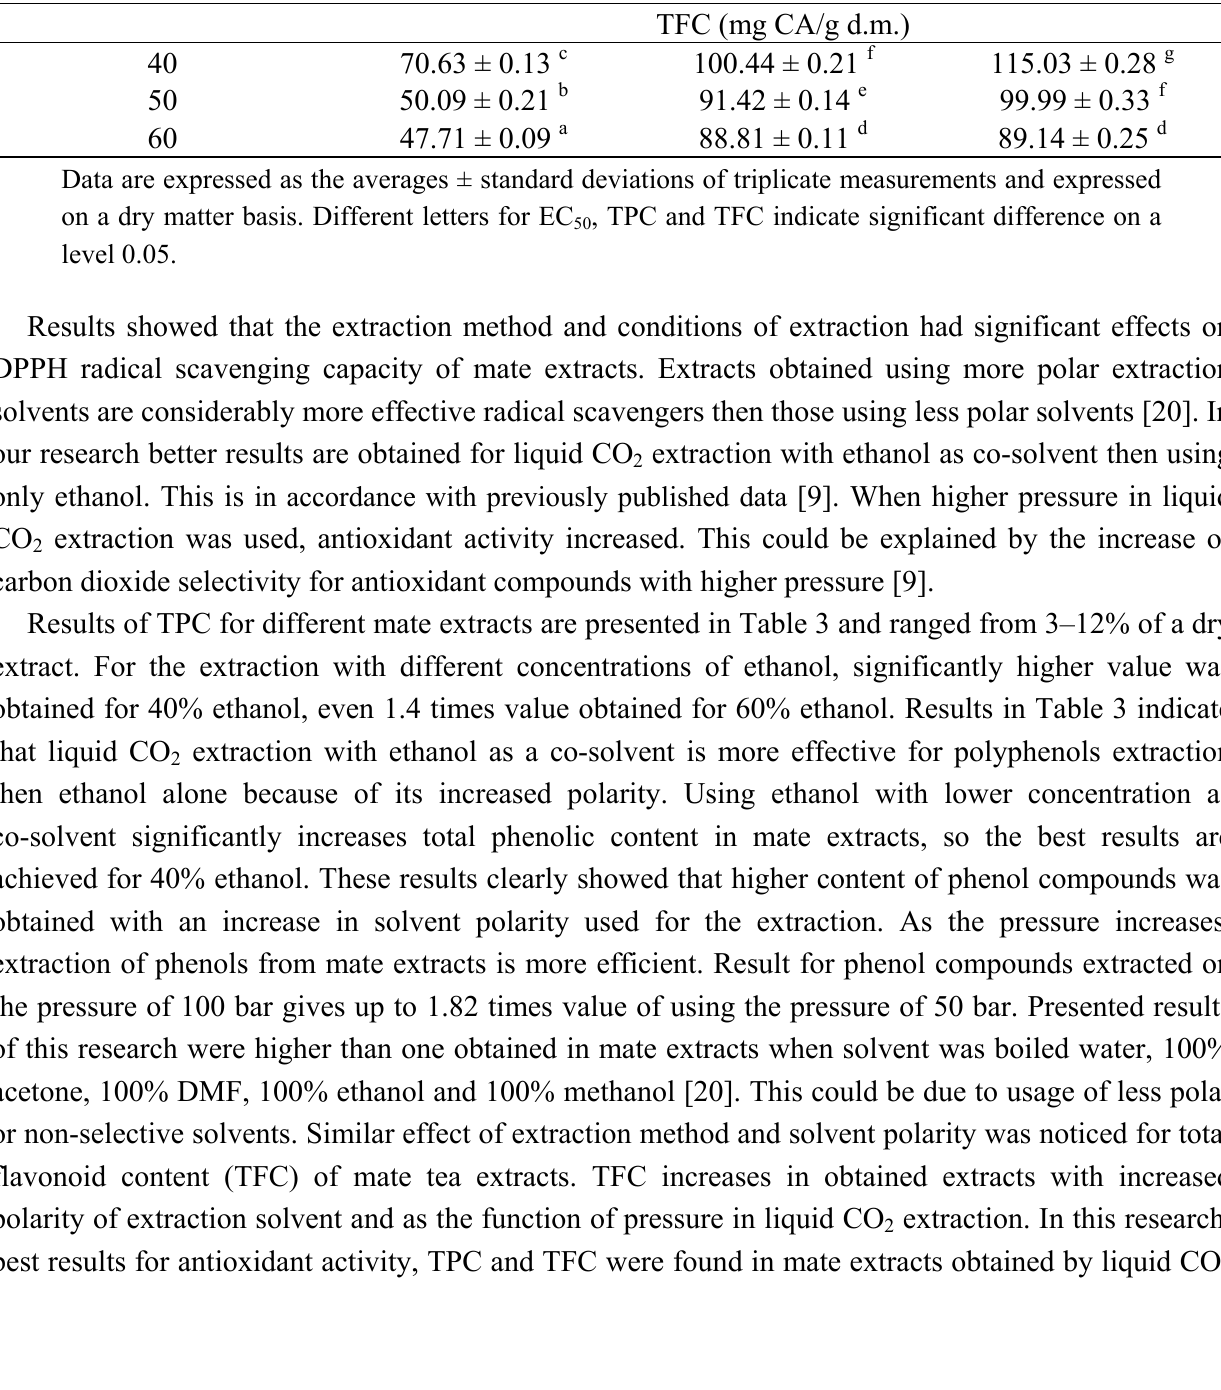
), total phenolic content (TPC) and total 50